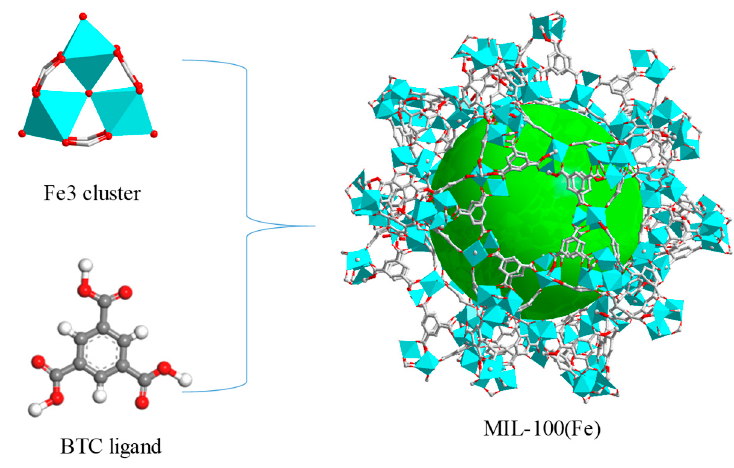
Figure 1. Schematic illustration of the construction of MIL-100(Fe).